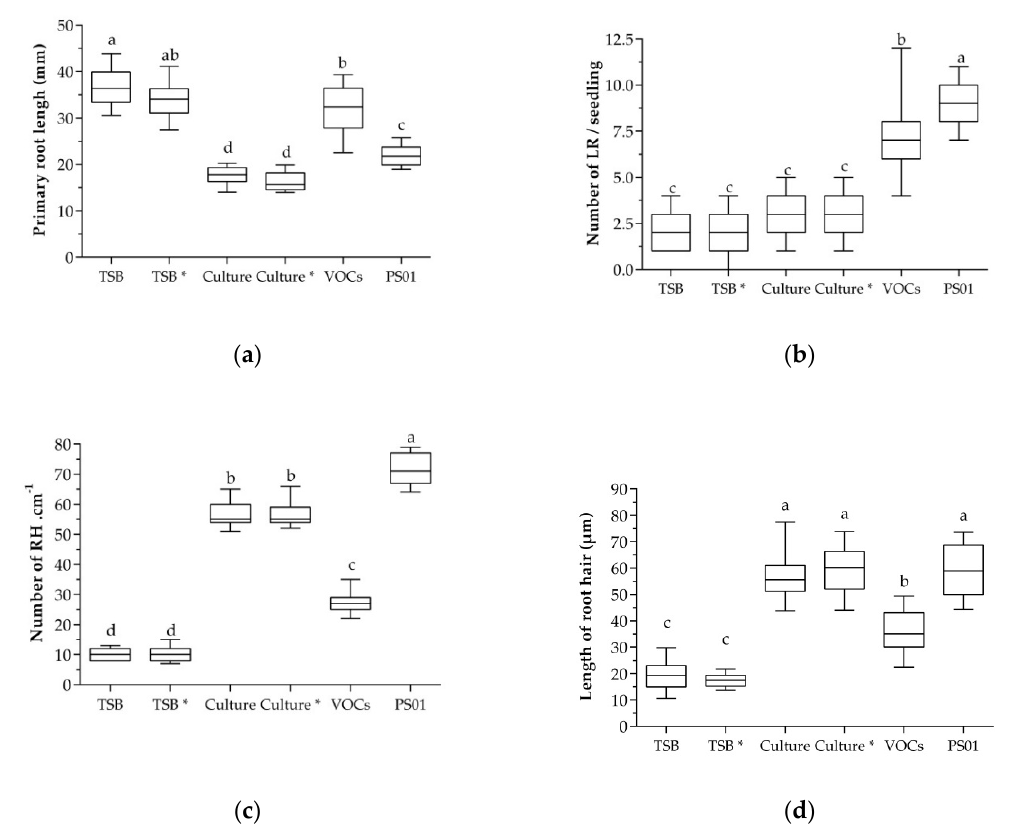
Figure 4. Di ff erent secreted metabolites produced by PS01 implicated in RSA of Arabidopsis . E ff ect of VOCs blend and di ff usible compounds on ( a ) primary root elongation; ( b ) LRs formation; ( c ) RHs density and ( d ) RHs length were assessed. Cell-free culture supernatant of PS01 growing on TSB medium supplemented with (Culture*) or without tryptophan (Culture) was prepared by filtration. Then, 20 µ L of filtrate was applied on a paper disk which was then placed in agar medium. TSB and TSB* (TSB supplemented with Trp) were used as control. VOCs treatment was performed by applying 20 µ L of bacterial suspension (10 6 CFU / mL) on a paper disk which was placed in the left side of the split plate. VOCs emitted by bacteria will expose to the seedlings at the left side. Data are depicted as boxplots representing the range of values, the exclusive median. Di ff erent letters indicate statistically significant di ff erences (Tukey’s HSD test; p <